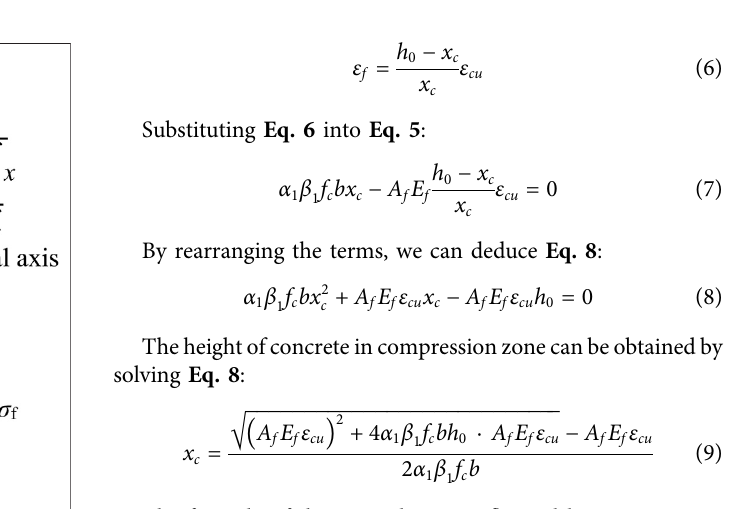
FIGURE 15 | Stress and strain distribution of beam section.